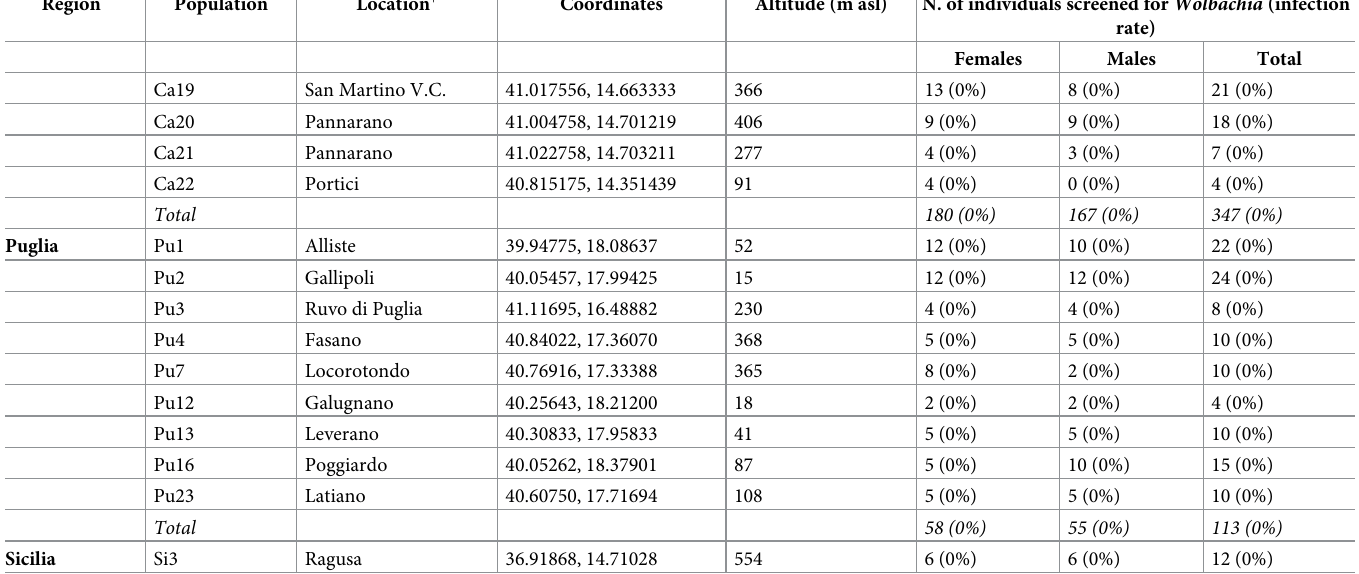
The sex ratio was assessed in five Wolbachia -infected populations of northern Italy (Alto Adige, Piemonte and Liguria) and 27 uninfected populations of southern Italy (Campania, Puglia and Sicilia) (S3 Table). The G-test of independence [73] was used to compare the sex ratio of P . spumarius populations within and between geographic regions.